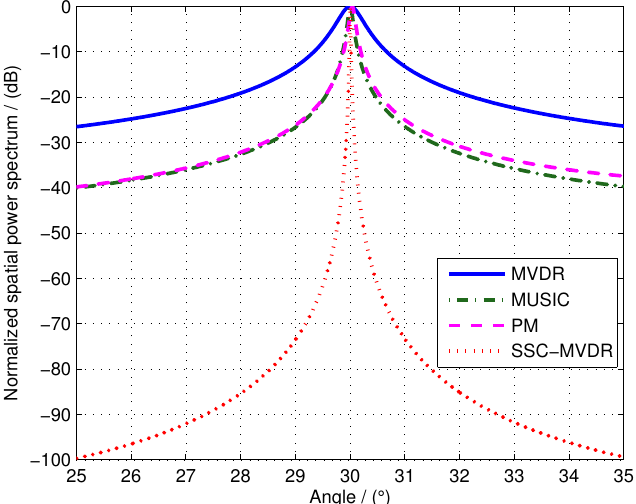
Figure 2. Normalized spatial power spectrums obtained by the MVDR method, the MUSIC method, the PM method and the SSC-MVDR method when the acoustic source intensity is 20 dB and the snapshot number is